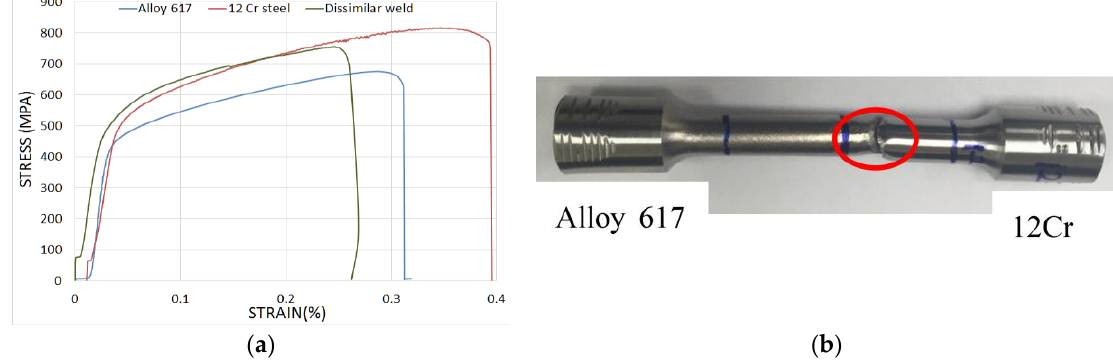
Figure 9. ( a ) σ-ε curves of dissimilar weld; ( b ) dissimilar weld fractured specimen.